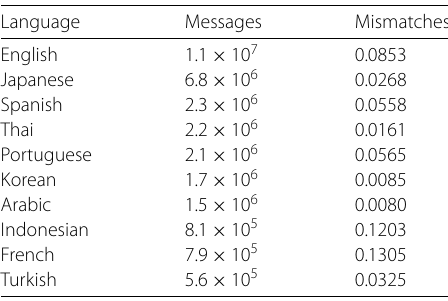
Table 6 Average daily messages for the top 10 languages between 2020-01-01 and 2020-01-07 (approximately 32 million messages for each day) Language